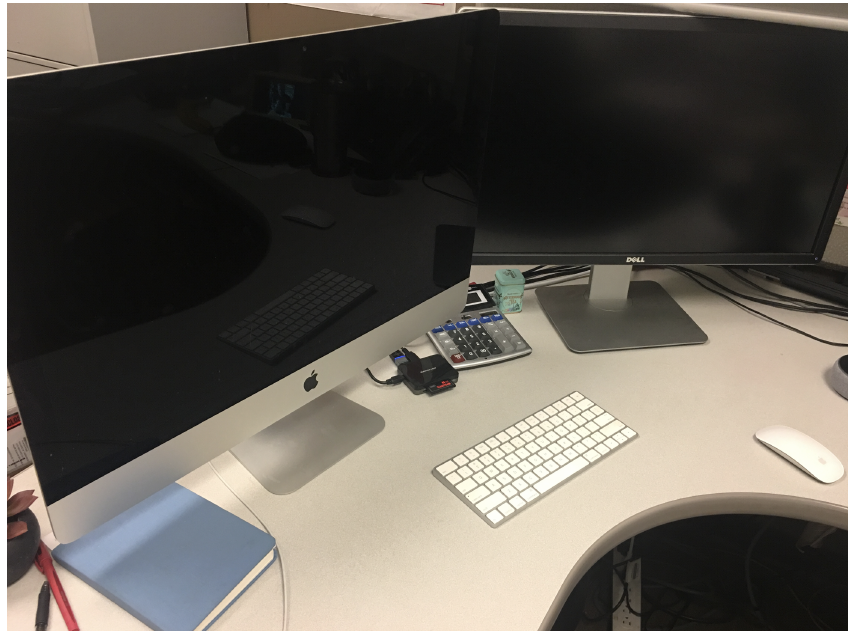
Figure 4. The user workspace of the workers that we interviewed is a fairly typical office space; thus, our focus is on providing guidelines for designing desktop-based